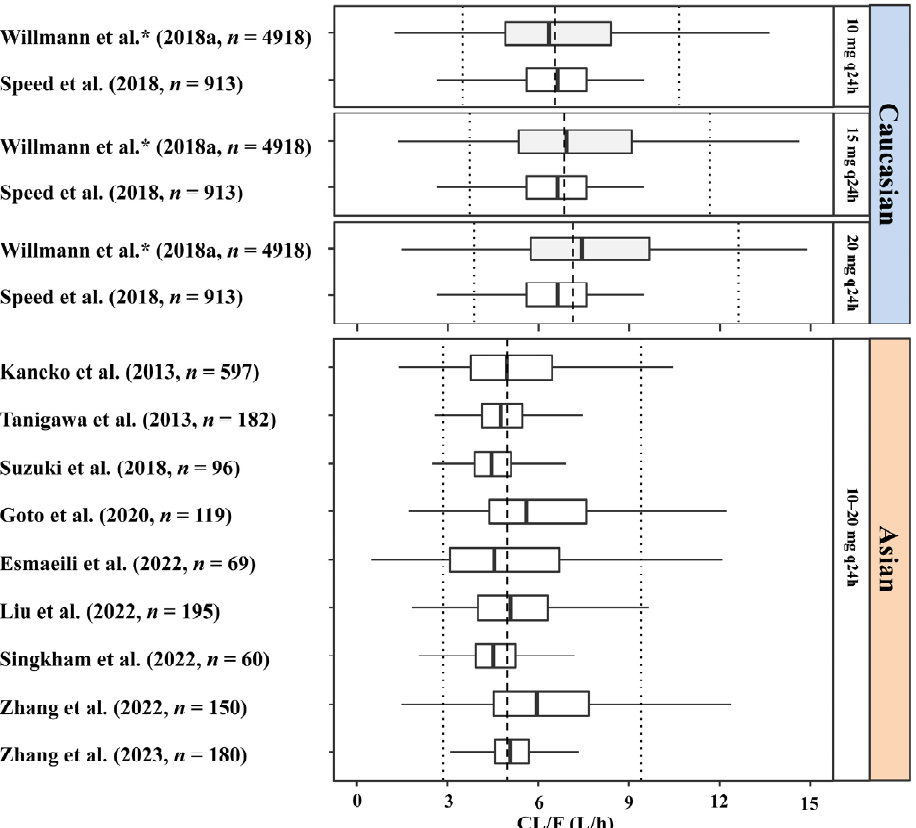
Figure 1. Apparent clearance of rivaroxaban in adult Caucasian and Asian patients with non-valvular atrial fibrillation taking 10–20 mg rivaroxaban. The typical patients of Caucasian and Asians were set as male, 60 years old, and had the following demographic parameters: body weight, 70 kg; lean body mass (LBM), 50 kg; serum creatinine, 1 mg/dL; creatinine clearance (CrCl, or estimated glomerular filtration rate [eGFR]), 80 mL/min; CrCl calculated with LBM, 60 mL/min; blood urea nitrogen, 16 mg/dL; hematocrit, 40%; albumin, 4 g/dL; alanine aminotransferase, 22 IU/L; total bilirubin, 14 μ mol/L; transformed Child–Turcotte–Pugh Score, 5.7; ABCB1 expression, 1.25; ABCB1 rs1045642, TT; ABCB1 rs4728709, GG; and without the co-administration of CYP3A4 inducers/inhibitors or P-gp inhibitors. The dashed and dotted lines in each panel represent the median, 5th, and 95th percentiles of the apparent clearance in each corresponding population, respectively. * The dose-dependent bioavailability (F) was estimated in study by Willmann et al. [18,25,26,30,31,33–38]. Covariates on the CL of rivaroxaban in previous studies included renal function [CrCl, eGFR, and blood urea nitrogen (BUN)], hepatic function [alanine aminotransferase (ALT), total bilirubin (TBIL), transformed Child–Turcotte–Pugh Score (CTP)], genetic polymorphisms of ABCB1 , and the presence of co-medication. The effects of the covariates on CL in each study are shown in Figure 2.